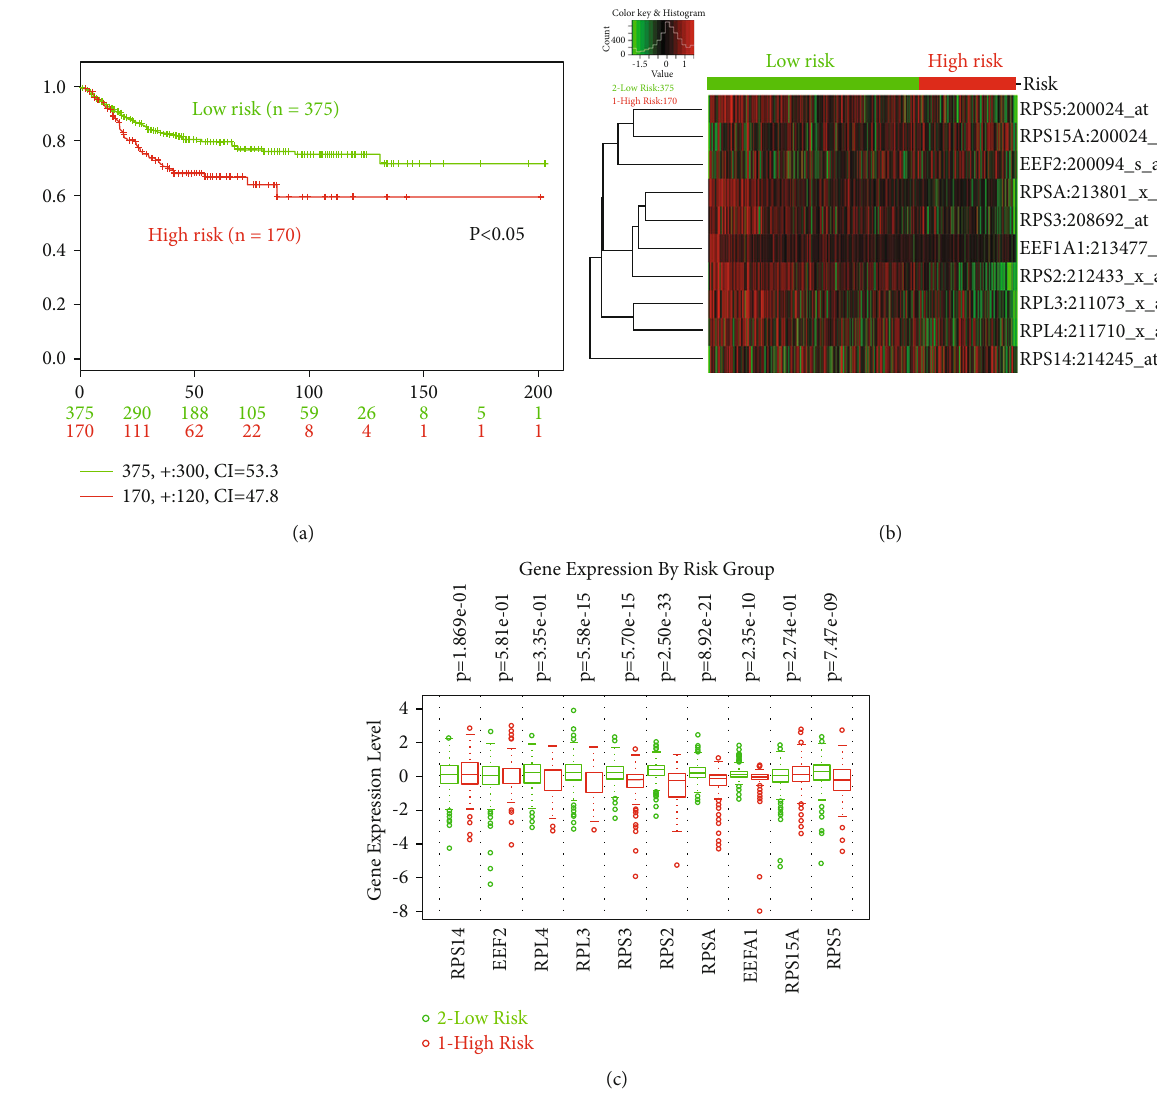
Figure 9: The prognostic values (disease-free survival, DFS) of hub gene signature in colorectal cancer via the SurvExpress platform. (a) The KM plot of high-/low-risk groups divided by prognostic index; (b) the mRNA expression of high-/low-risk DFS groups in heat map; (c) the mRNA expression comparison between high- and low-risk DFS groups. High risk: red; low risk: